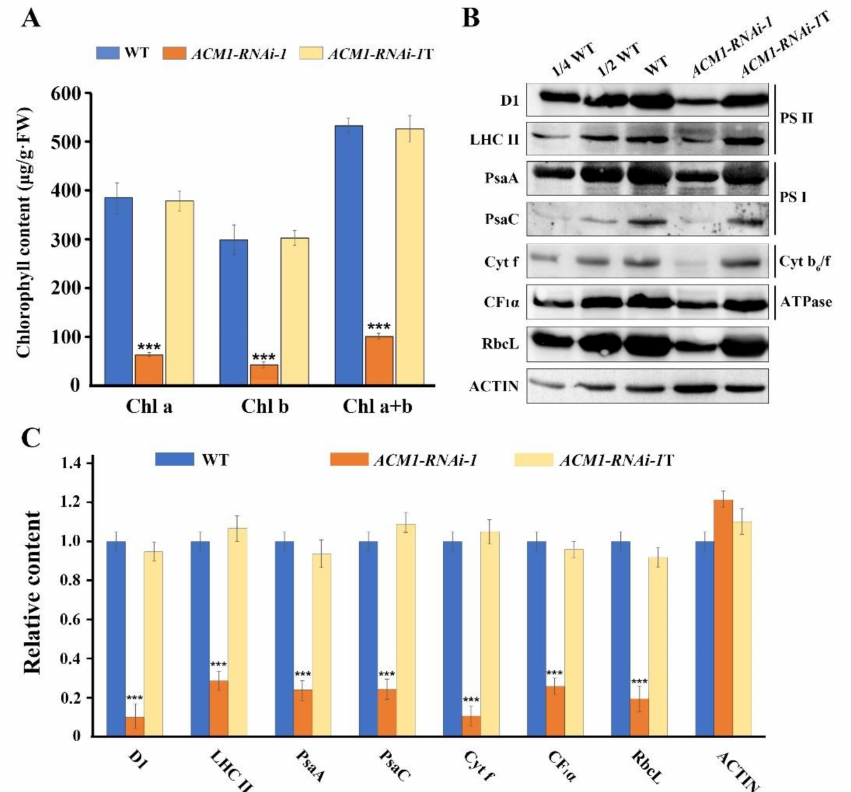
Figure 5. The content of chlorophyll and photosynthetic proteins. ( A ) Chlorophyll content of WT and ACM1 -RNAi-1 seedlings. Chlorophyll was quantified from 7-day-old seedlings cotyledons and 14-day-old seedlings’ true leaves. Values given are µ g/g fresh weight ± SD. The asterisks indicate significant differences (Student’s t-test; *** p < 0.001). The average of three replicates is shown. ( B ) Immunoblot analysis of photosynthetic proteins. Total proteins from 7-day-old cotyledons and 14-day-old true leaves of WT and ACM1 -RNAi-1 were separated by 10% SDS-PAGE (Sodium dodecyl sulfate polyacrylamide gel electrophoresis). Probed using specific anti-D1, anti-LHCII, anti-PsaA, anti-PsaC, anti-Cyt f, anti-CF1 α , and anti-RbcL. ACTIN is used as a control. The experiments were repeated three times at least with similar results. ( C ) Proteins immunodetected from ( A ) were analyzed by ImageJ software. Values (means ± SE; n = 3 independent biological replicates) are given as ratios to protein amounts of the WT and ACM1 -RANi-1. *** P < 0.001, by Student’s t-test. T refers to the proteins in true leaves of ACM1 -RNAi-1